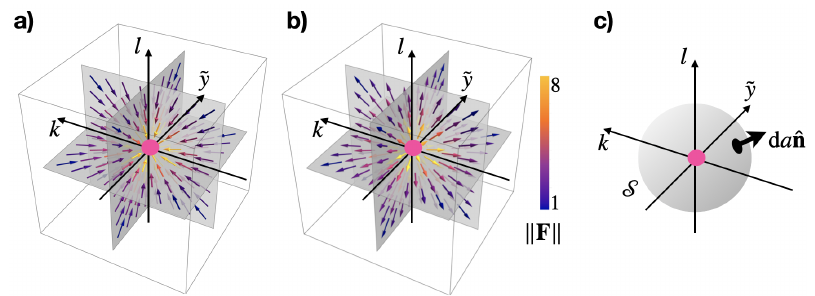
Figure 4: a) Berry curvature F vector field of the Matsuno symbol (55) for the neg- ative Poincaré band. b) The same for the positive Poincaré band. Both diverge in amplitude at ( k , l , ˜ y ) = ( 0,0,0 ) . c) An integral of the flux of this vector field on any closed surface S enclosing this point evaluates to − 4 π and 4 π , for the nega- tive and positive Poincaré bands respectively. The pink dot represents a Berry-Chern monopole of charge ± 2 that can be interpreted as the source of observed Berry cur-